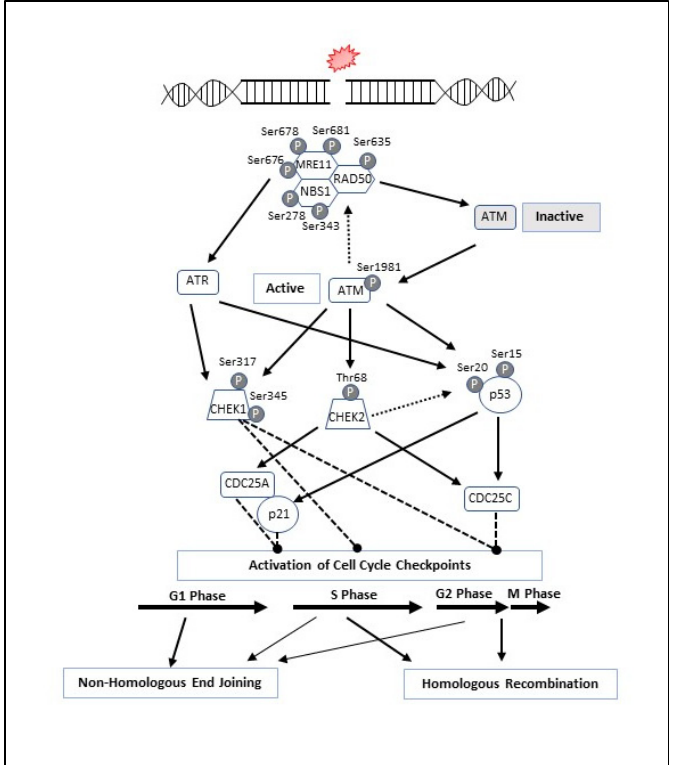
Figure 2. DNA Repair Pathways; Protein Recruitment and Cell Cycle Activation. After a DSB, The MRN complex locates to the site of damage and recruits and helps activate ATM stimulating its phosphorylation at Ser1981. Activated ATM phosphorylates all three MRN proteins; NBS1 on sites Ser278 and Ser343, RAD50 on site Ser635, and Mre11 on sites Ser676, Ser678 and Ser681. The activation of ATM results in multiple downstream events including activation of p53 by phosphorylation at Ser15 and Ser20, and CHEK2 at Th68. Active p53 and CHEK2 in-turn activate different cell cycle checkpoints. Activation of ATR results in the phosphorylation of CHEK1 on Ser317 and Ser345. ATR can also catalyze phosphorylation of p53 at Ser15 and Ser20 as the catalytic subunit of DNA-PKcs. The activation of cell cycle checkpoints at different stages often determines the method of repair and which additional proteins need to be recruited. In addition to the MRN complex, each method of repair replies upon other proteins involved in the pathway to facilitated DNA double-stranded repair. CHEK2 activation occurs via phosphorylation by ATM at Thr68, resulting in dimeriza- leads to genomic stabilization at the site of DNA damage repair [63,64]. Active CHEK2 can arrest the cell cycle in G1/S or G2/M phase by phosphorylation of CDC25A or CDC25C, respectively. Additionally, arresting the cell cycle in G1/S phase can be promoted by CHEK2 via phosphorylation of p53. Once phosphorylated by ATM and/or CHEK2, active p53 induces G1 arrest through p21 activation. Additionally, p53 is involved in maintaining the G2/M checkpoint by transcriptional repression of